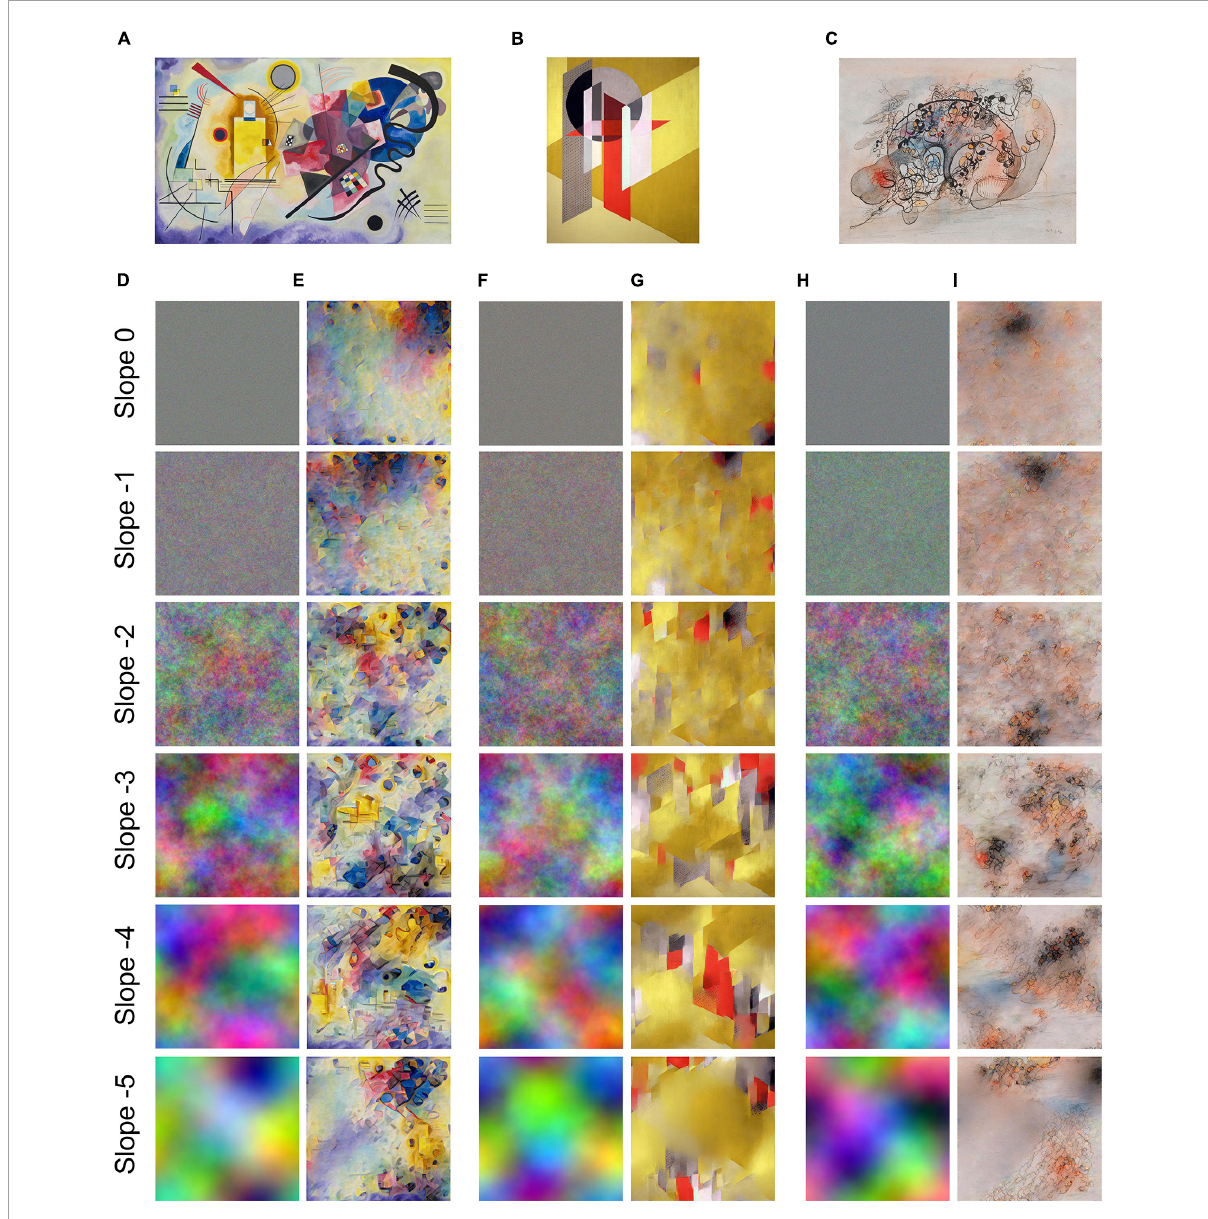
FIGURE1 Examples of the three image categories studied. Original artworks (A–C) are shown on top of the random-phase images (D,F,H) that were used to generate the style-transferred images (E,G,I) , respectively. The slope of the log-log plots of Fourier power vs. spatial frequency is indicated on the left-hand side of each row. Original artworks are (A) Gelb-Rot-Blau by Wassily Kandinsky (1925); (B) Z VII by László Moholy-Nagy (1926); and (C) Untitled by WOLS, ca.